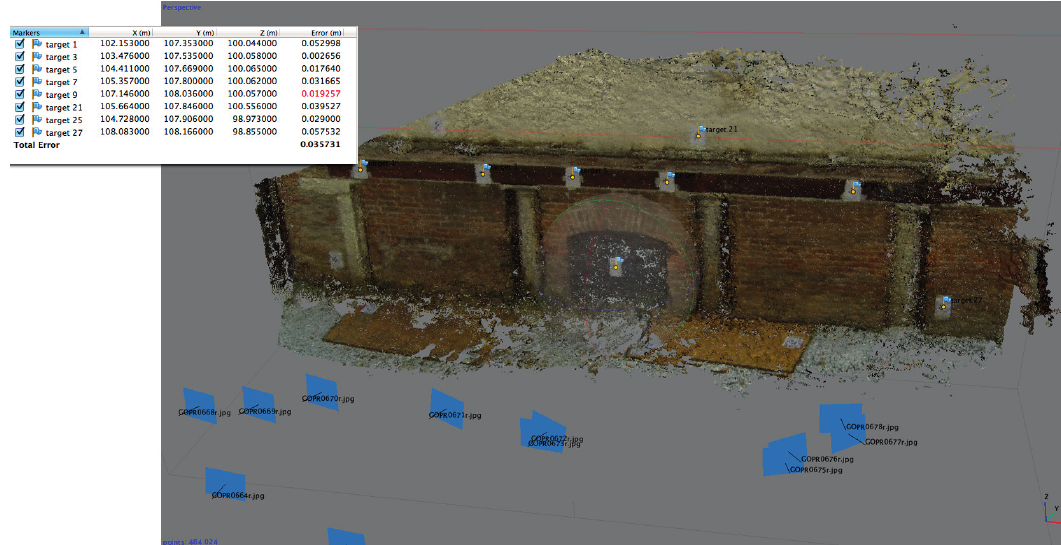
Figure 15. The dense point cloud obtained using undistorted oblique images. RMS error of collected GCPs is about 0.035 m. The test shows that perpendicular undistorted images allow to obtain a higher